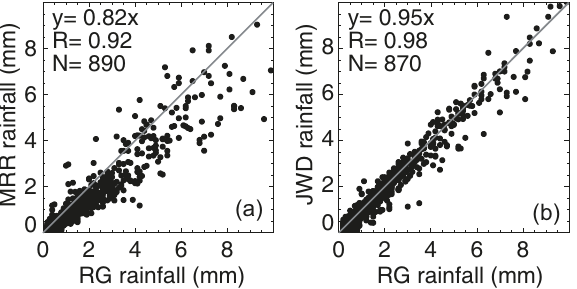
Figure 2. Scatterplots of the 1 h rainfall measured by ( a ) the rain gauge (RG) and the MRR and ( b )